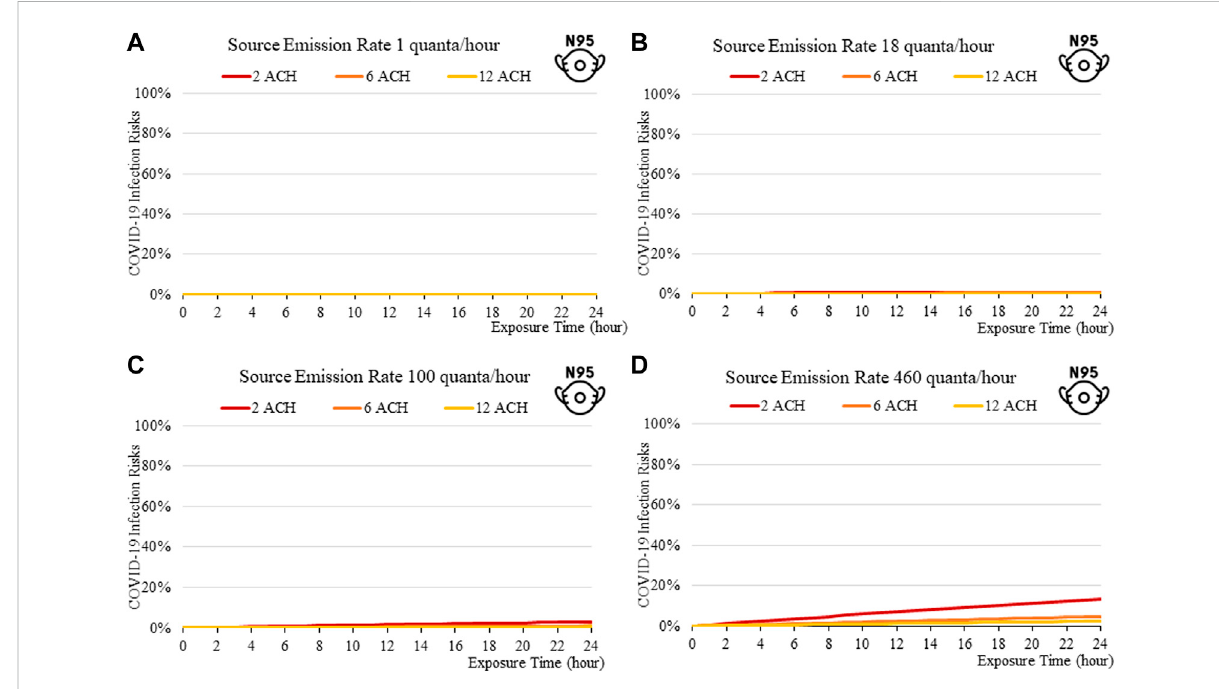
Disease infection risks for the original variant, assuming the receiver and the index patient are both wearing N95 respirators with the exhale quanta emission rate of 1 (A) , 18 (B) , 100 (C) , and 460 (D) quanta/hour for the